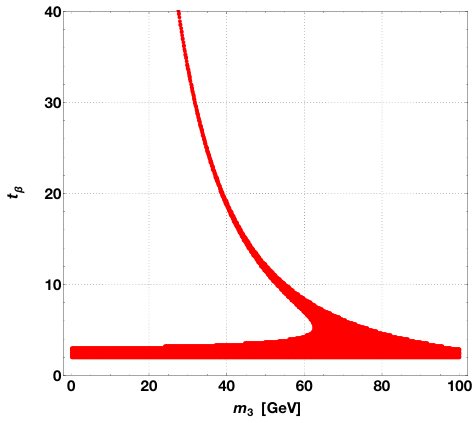
Figure 1 . The region of interest, where stability, unitarity, and perturbativity constraints are obeyed, is plotted as a function of the soft symmetry breaking term m 2